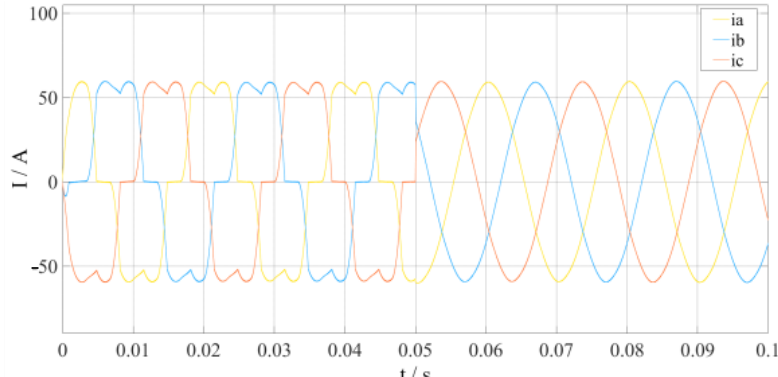
Figure 16. Mode 2 grid current diagram.